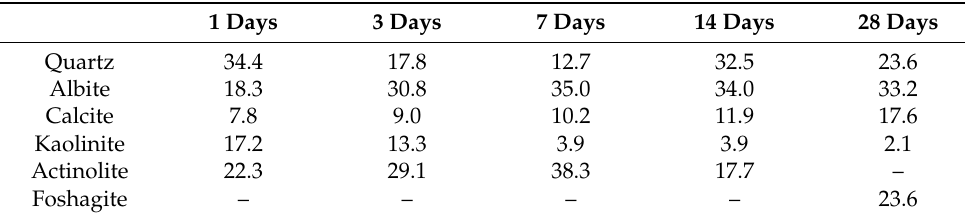
Figure 9. XRD of CPB samples with the optimal mix ratios at different ages (quartz: PDF 00-046-1045; kaolinite: PDF 01-078-2110; albite: PDF 00-009-0466; foshagite: PDF 01-074-0360; calcite: PDF 01-083-0577; and actinolite: PDF 01-085-2157). Table 5. Contents of mineral components in CPB samples with the optimal mix ratios at different ages